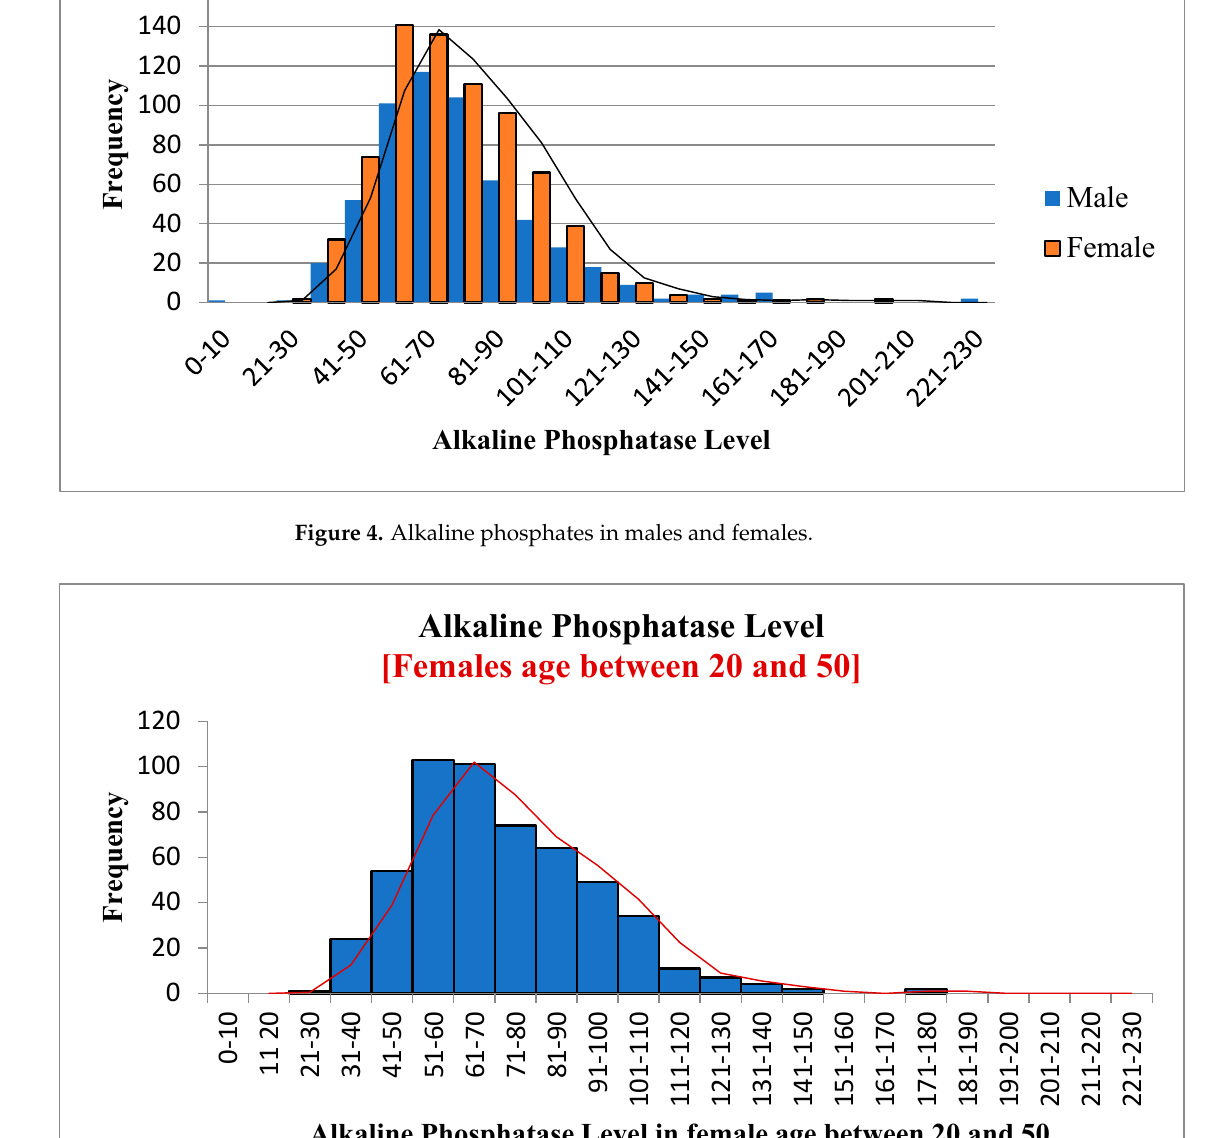
Figure 6. Alkaline phosphates in females over 50. Table 2 shows the numbers and percentages of the different vitamin D levels, PTH, and ALK in categories from deficient to normal. The results show that many patients (i.e., 47%) had a normal level of 25OHD, followed by 30% who had insufficiency, 12% who had a mild deficiency, 7% who had a moderate deficiency, and 3% who had severe deficiency. Levels of PTH were also found to be normal in 74% of samples, followed by 25% with increased levels and 1% with low PTH levels. ALP levels were normal in 91% of the sam- ples, whereas 9% were high, and 1% exhibited a low level of ALP. Table 2. Frequency and percentage of vitamin D, ALK, and PTH levels (N = 1311). Classification